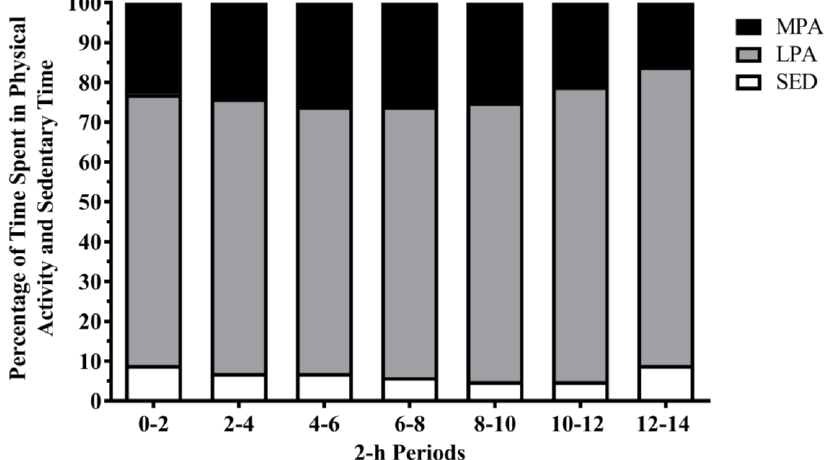
Figure 2. Proportion of time spent in physical activity and sedentary time during each 2-h period across a planned burn shift. Data are displayed as mean values (SD). SED = sedentary time; LPA = light-intensity physical activity; MPA = moderate-intensity physical activity. 0–2 h: n = 34; 2–4 h: n = 34; 4–6 h: n = 34; 6–8 h: n = 34; 8–10 h: n = 33; 10–12 h: n = 31; 12–14 h: n = 30.